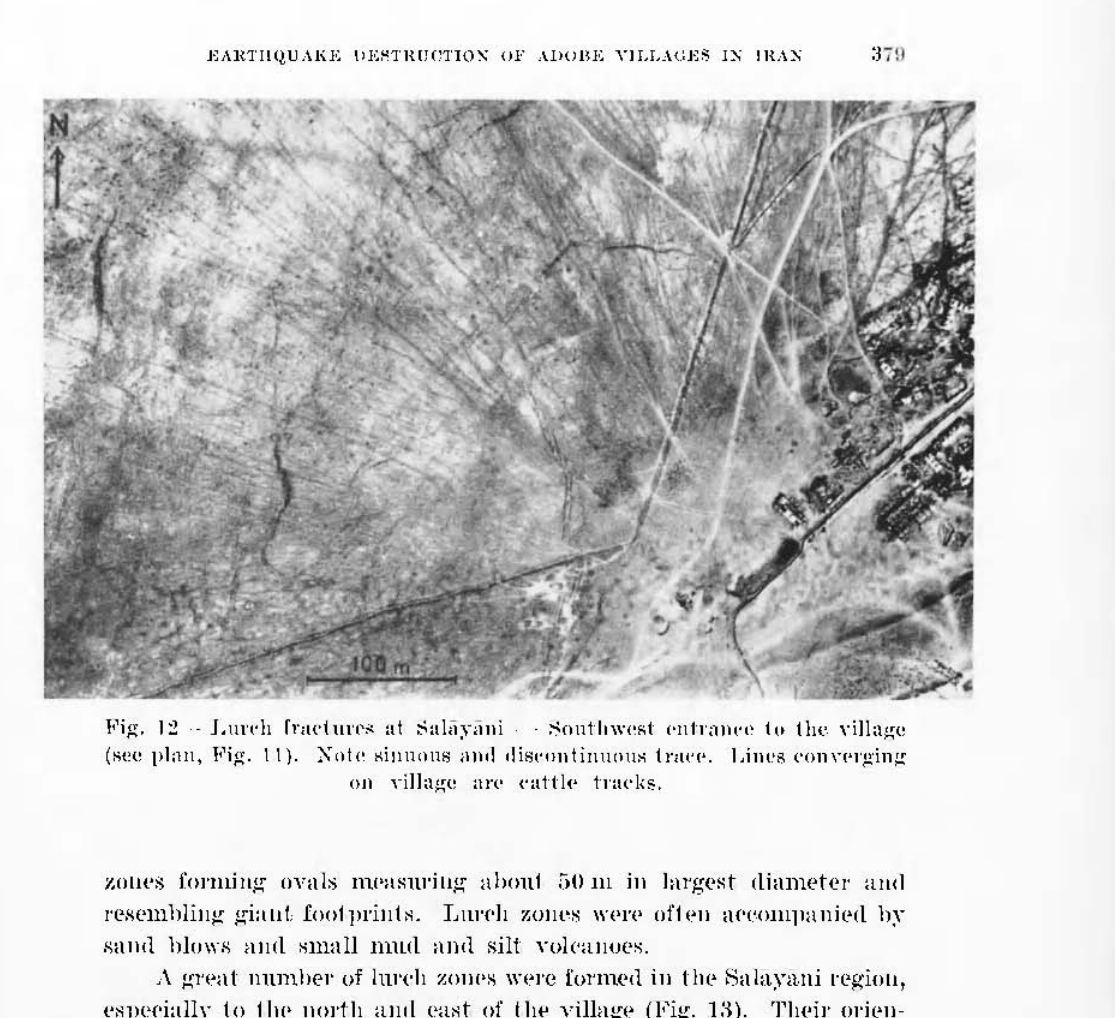
Fig, l:l - J.U\'('h [radu\'l'i< at ;:;aj,l~-iilli ;-:;()lltll\\"('~t t'lllT,l1l('P h. tlll' "illage (HI'e plnll, Fig. \ \ l. XOtl' KillllOllS ;llloi oIis('UlltillUOUH tnu'p. Lillt'S ('Onl·pr).!,"Ìnl! OH yillage an' ('atth'